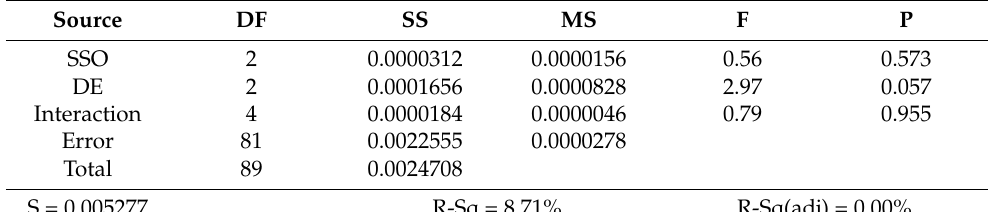
Table 11. Two-way ANOVA—transition.